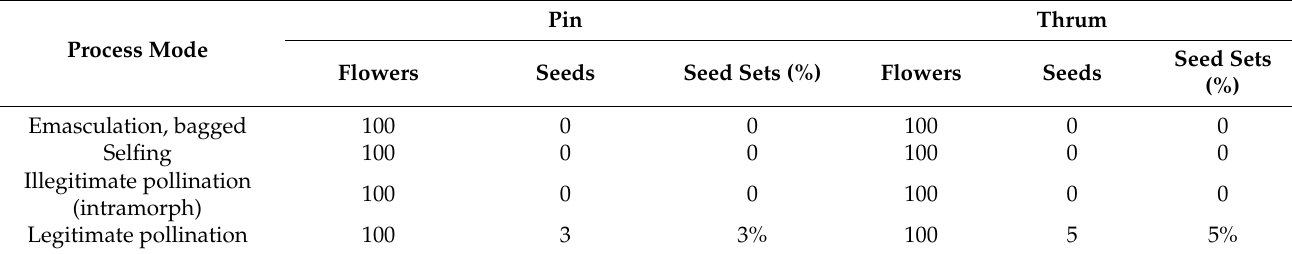
Table 6. Seed set rate under different treatment